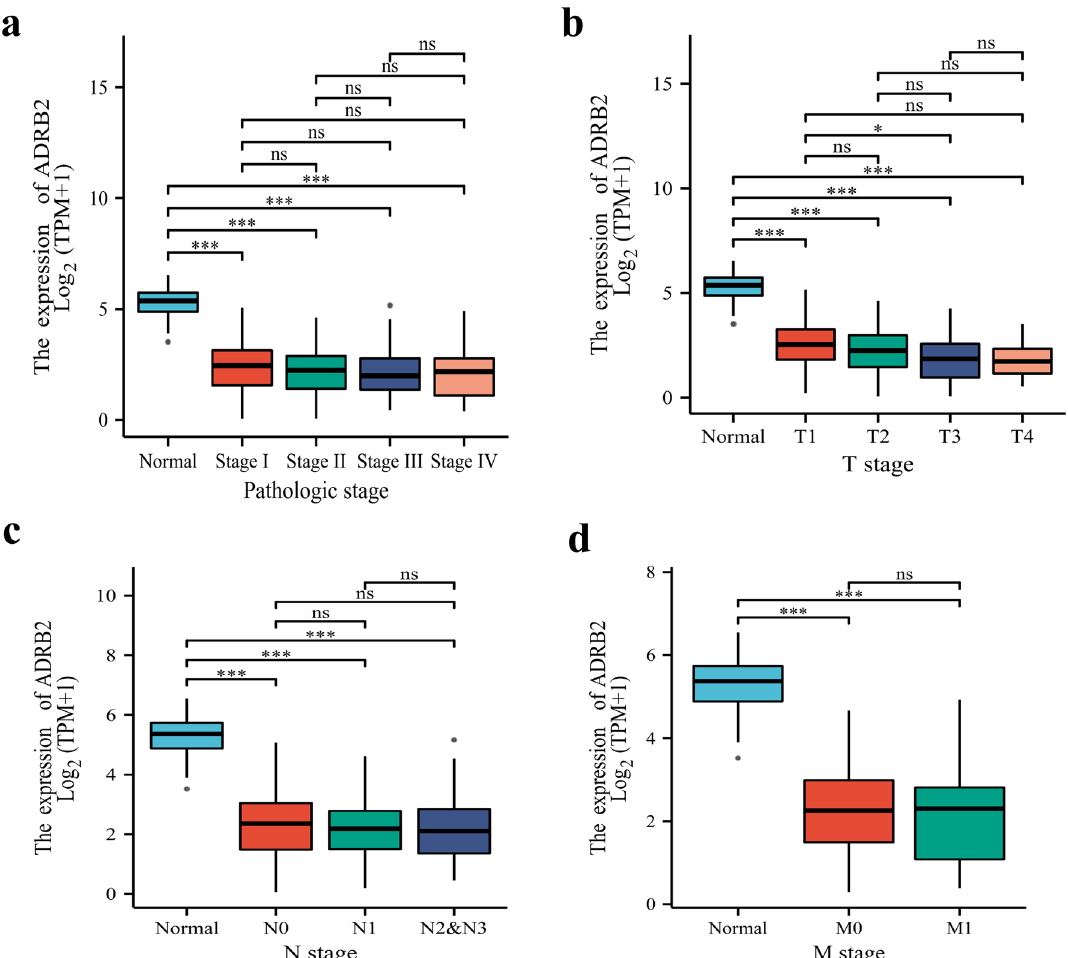
Figure 2. The expression of ADRB2 is grouped by pathological stage ( a ), T stage ( b ), T stage ( c ), and M stage ( d ). *P < 0.05, **P < 0.01, ***P < 0.001, ns not significance.